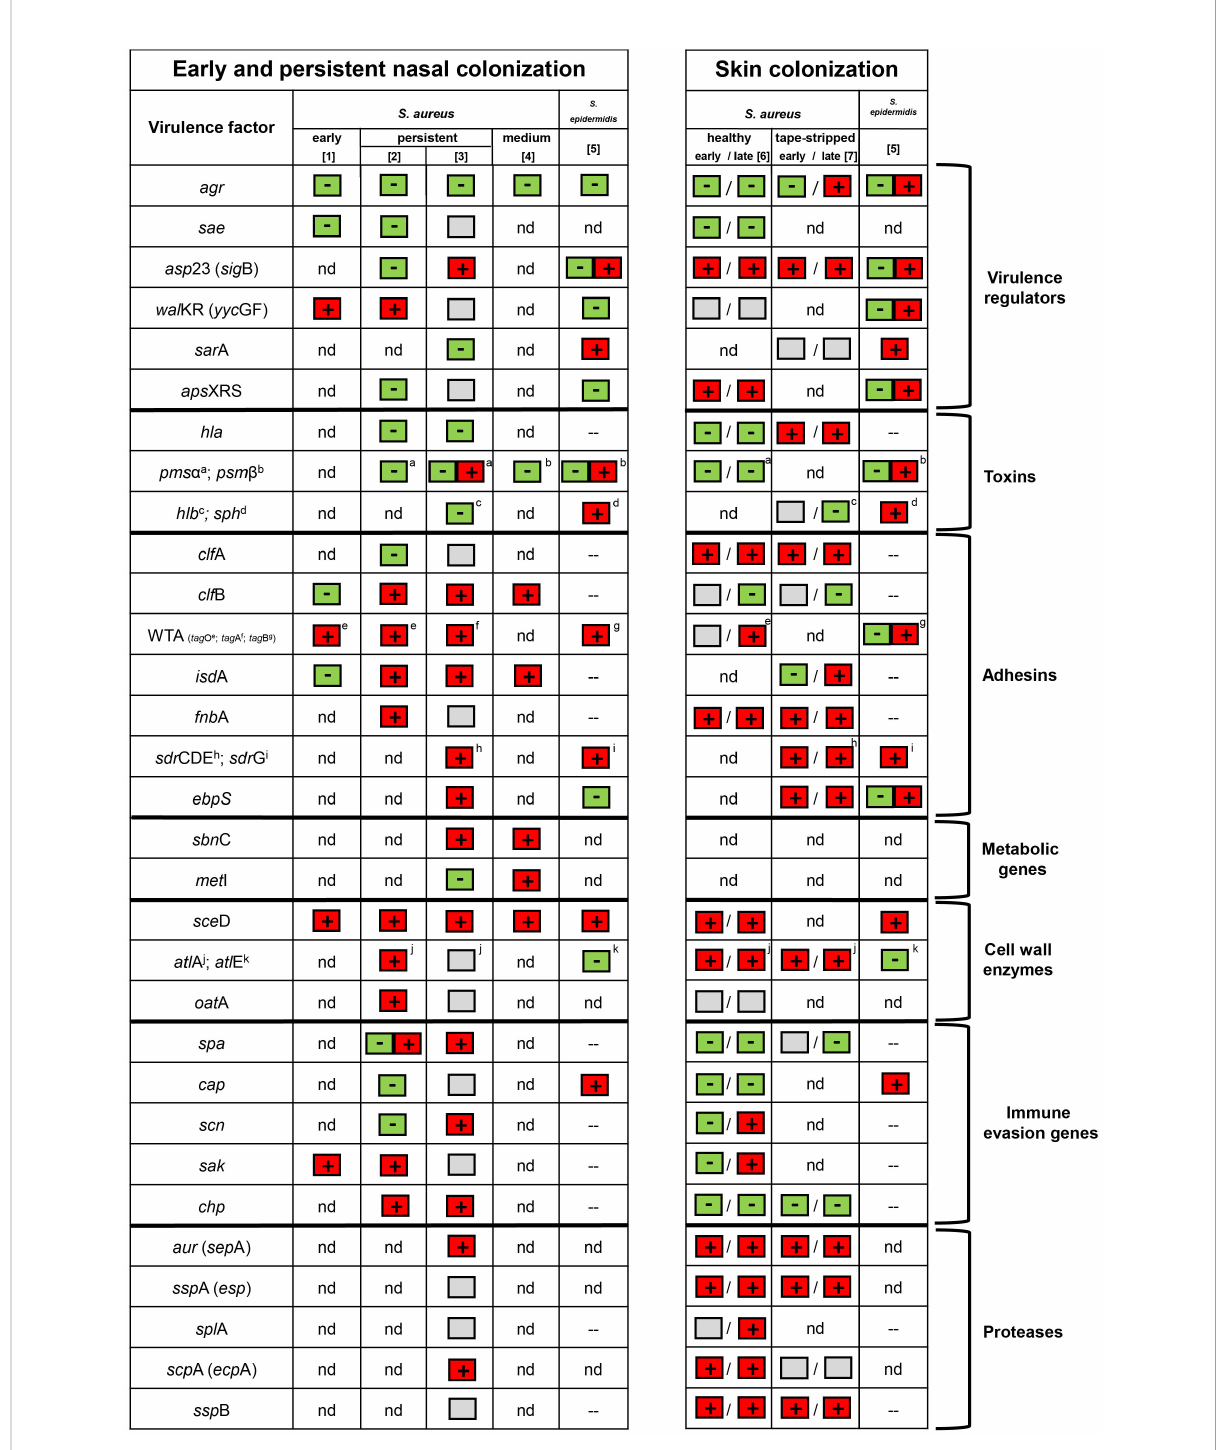
FIGURE 1 Transcriptional patterns in the nose and skin of S. aureus and S. epidermidis based on the following literature: 1 = (Burian et al., 2010a); 2 = (Burian et al., 2010b); 3 = (Chaves-Moreno et al., 2016); 4 = (Krismer et al., 2014); 5 = (Teichmann et al., 2022); 6 = (Burian et al., 2021); and 7 = (Cruz et al., 2021). Genes upregulated were marked with a + (box with red background), while genes downregulated were marked with a – (box with green background). The box with a gray background indicates no regulation. A box with + and – (red and green background) indicates heterogeneous transcription. nd = not determined. – = not